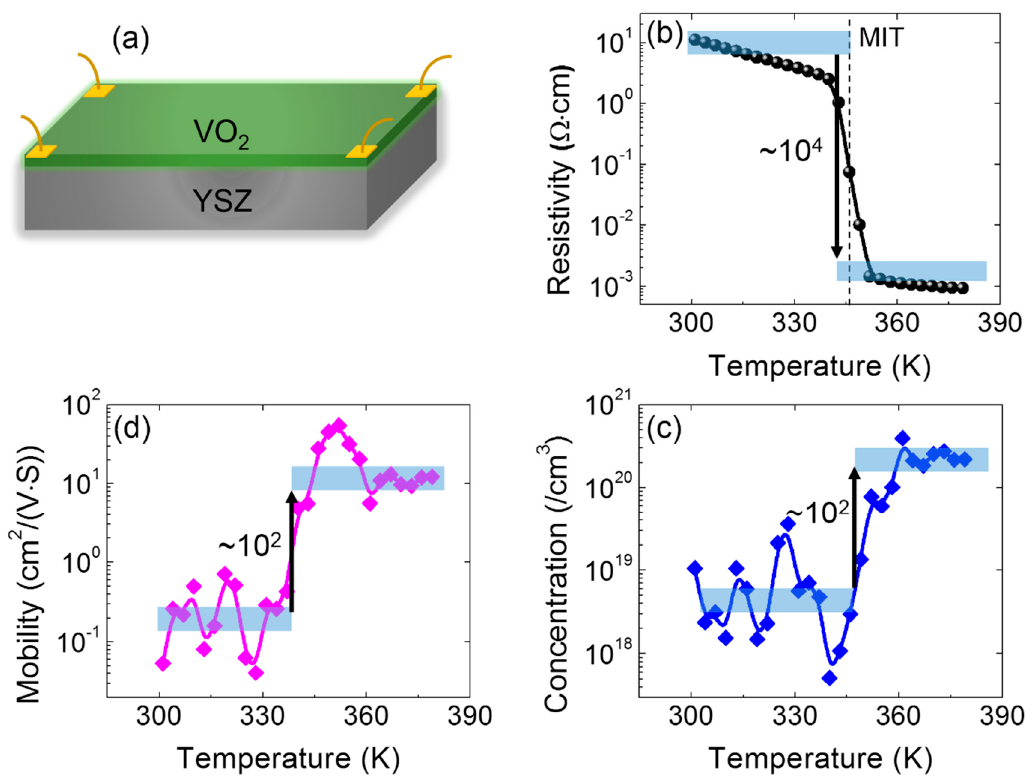
Figure 2. Metal–insulator transition characterizations. ( a ) The schematic of the transport measurement using the van der Pauw method; ( b ) the resistivity vs. temperature curve; ( c ) the electron mobility and ( d ) concentration as temperature increases.